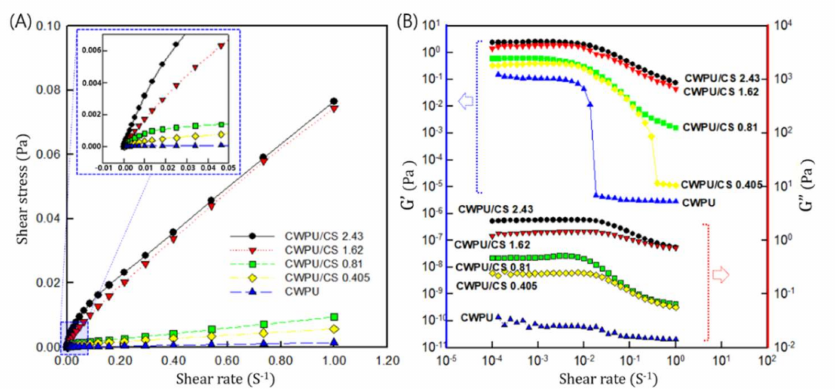
Figure 3. Steady-shear behavior of CWPU and CWPU/CS nanocomposites with various CS contents: ( A ) dependence of the shear stress on the shear rate; and ( B ) dependence of the modulus on the shear